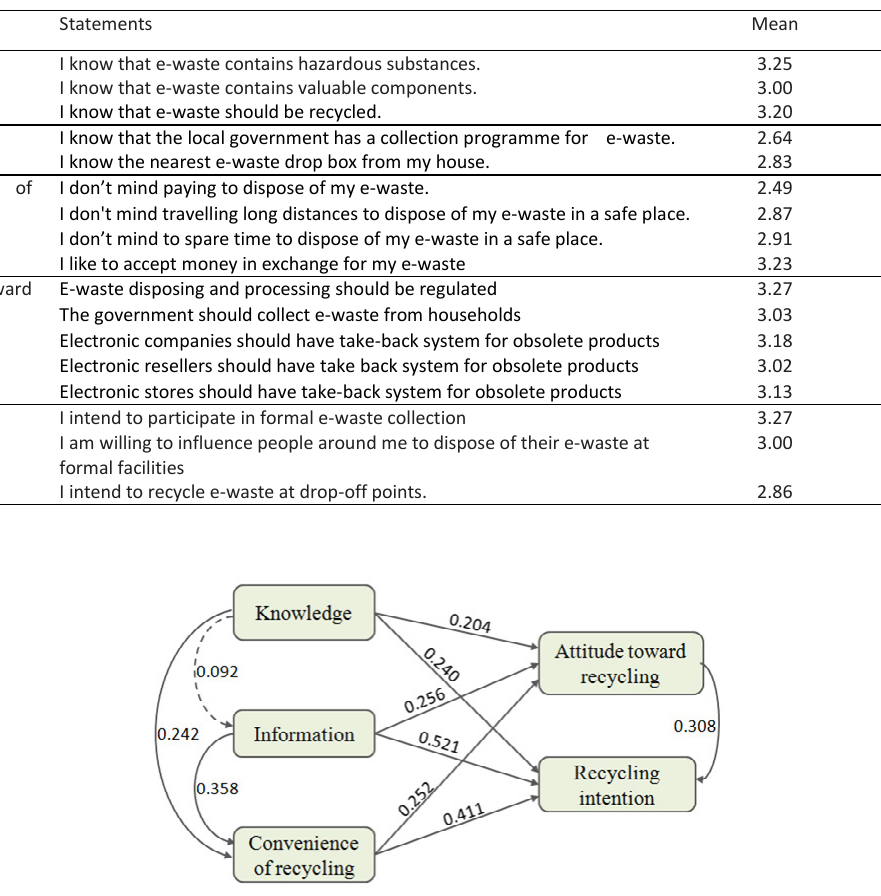
Table 2: Responses summary of the survey